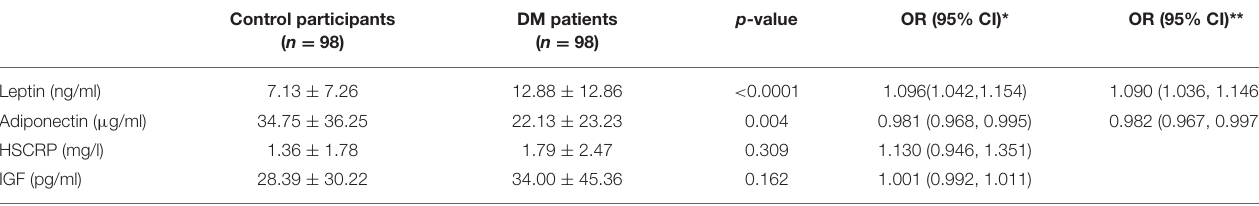
TABLE 3 | The distribution of biomarkers between the study groups.